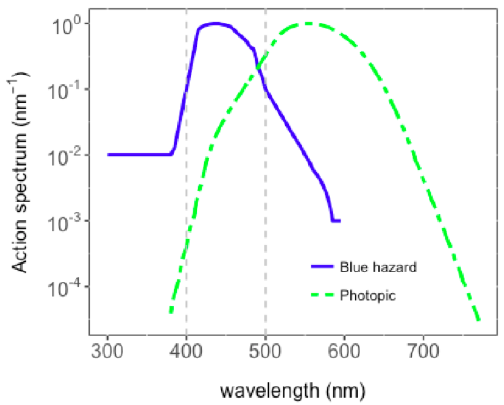
Figure 1. Action spectra for blue light hazard and for photopic vision. The ordinate axis is represented in a log scale to show the large differences between wavelengths. The two dashed vertical lines represent the blue light range from 400 to 500 nm.